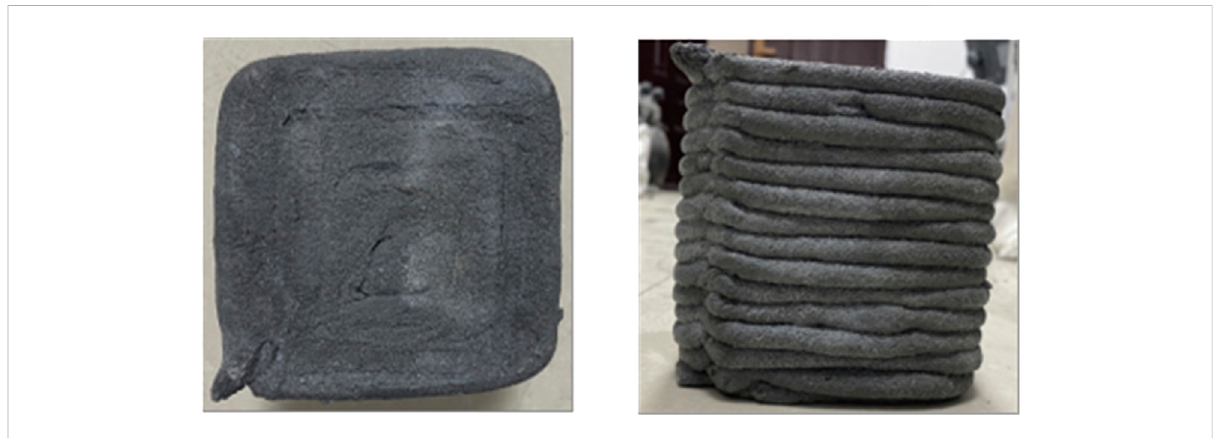
FIGURE 2 3D printed concrete samples.